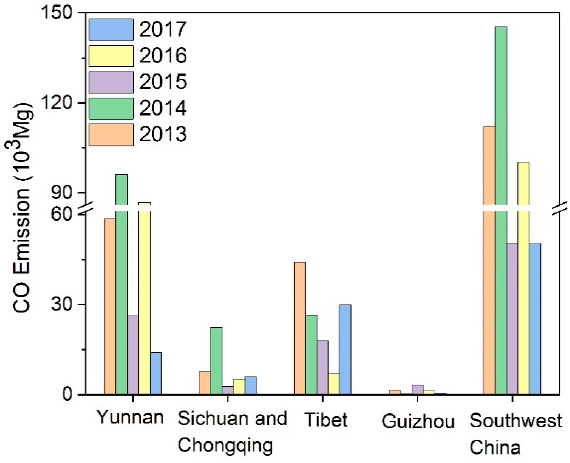
Figure 5. CO emissions of forest fires from 2013 to 2017 in southwest China.